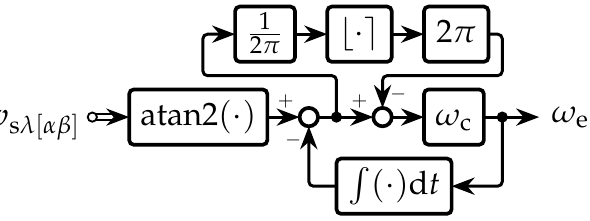
Figure 3. A diagram of the proposed observer of ω e